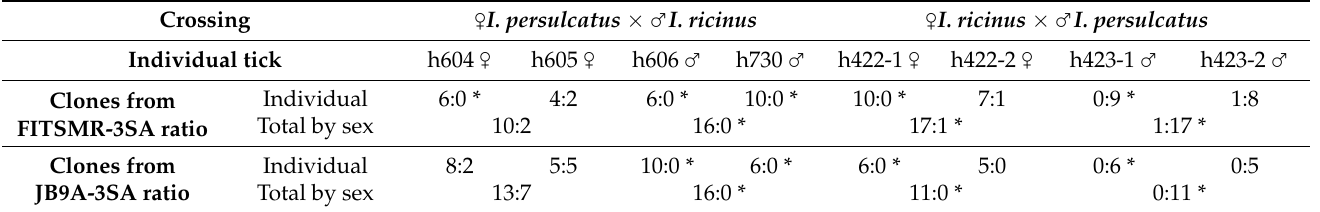
Table 4. Ratios of I. persulcatus : I. ricinus molecular clones of the ITS2 region obtained for hybrid